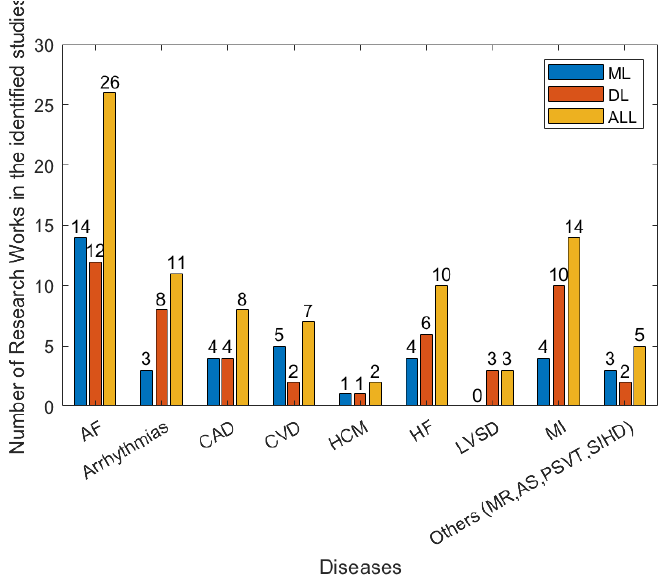
Figure 7. The numbers of types of disease in the 79 studies between January 2018 and April 2022 that are related to detection/prediction from the identified studies.